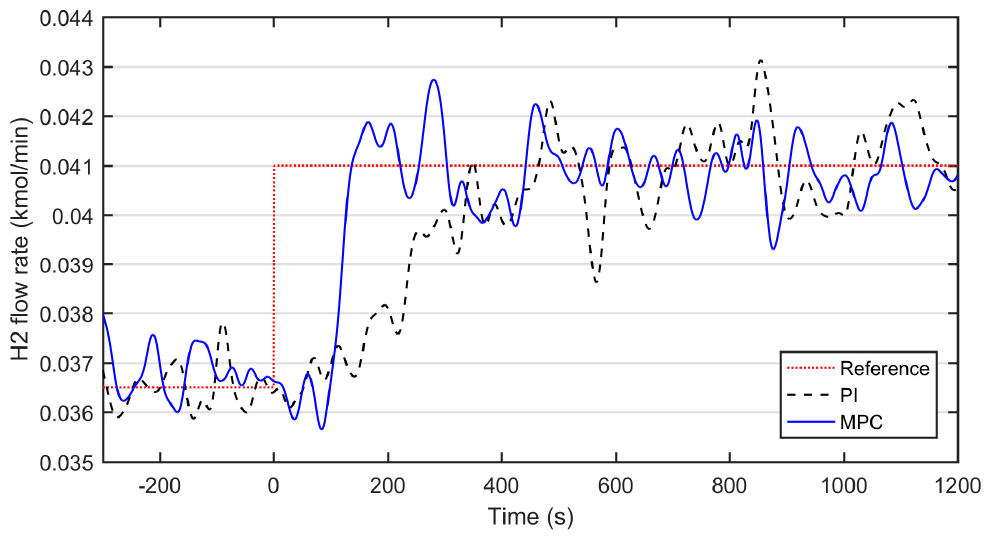
Figure 6. Simulated control results of the MPC and PI controller during a step change in the required hydrogen flow rate.